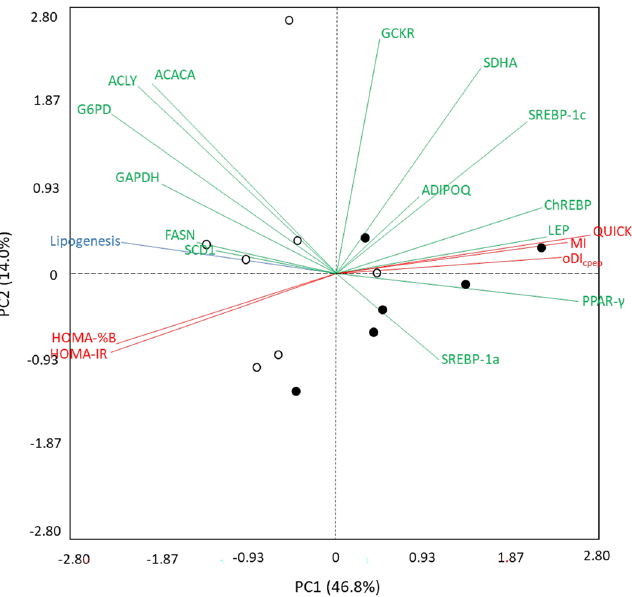
Figure 5. Principal components analysis (PCA) constructed with the gene expression (green), insulin sensitivity/secretion indexes (red) and stable isotopes (blue) variables of fat (open circle) and lean (filled circle) pigs. PC principal component, ACACA acetyl CoA carboxylase alpha, ACLY ATP citrate lyase, ADIPOQ adiponectin, ChREBP MLX interacting protein like, FASN fatty acid synthase, GAPDH